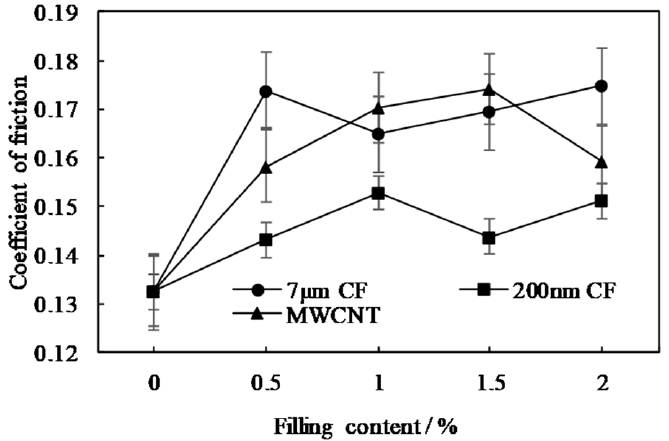
Figure 12. Friction coefficient of micro/nano CF and MWCNT filled modified PTFE composites.